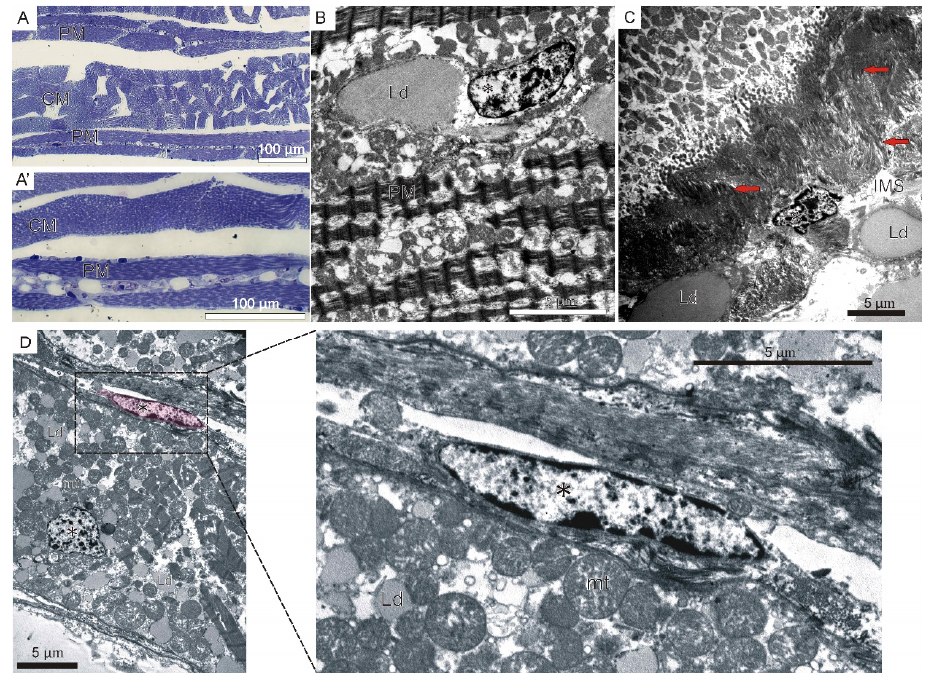
Figure 5. Adult musculature of river lamprey ( L. fluviatilis ). ( A ) Longitudinal sections of trunk muscles stained with methylene blue. Four central muscle fibers (CM), surrounded by groups of parietal muscle (PM) fibers. ( A’ ) Zoomed view of CM and PM. ( B ) Ultrastructure of parietal muscles. ( C ) Ultrastructure of muscle–tendon junction. ( D ) Ultrastructure of muscle satellite-cell precursor (colored in pink) located along fiber. The proximity of the cell is shown in the enlarged photogram. Lipid droplets (Ld), nuclei (*), collagen fibers (red arrows), intermyotomal space (IMS), mitochondria (mt).